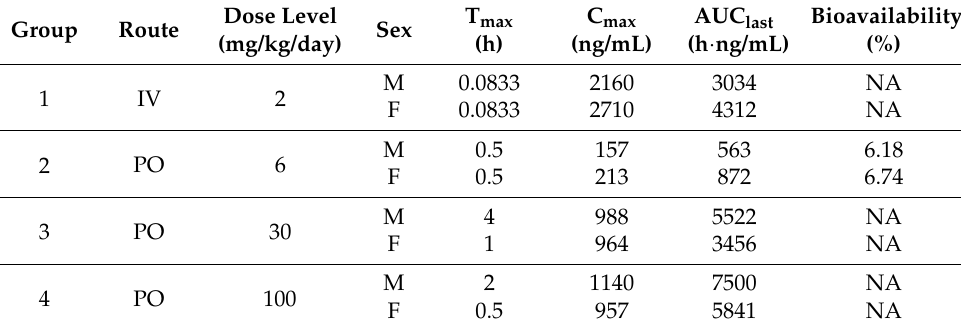
Table 4. Summary of ZB716 single-dose PK parameters in dog plasma